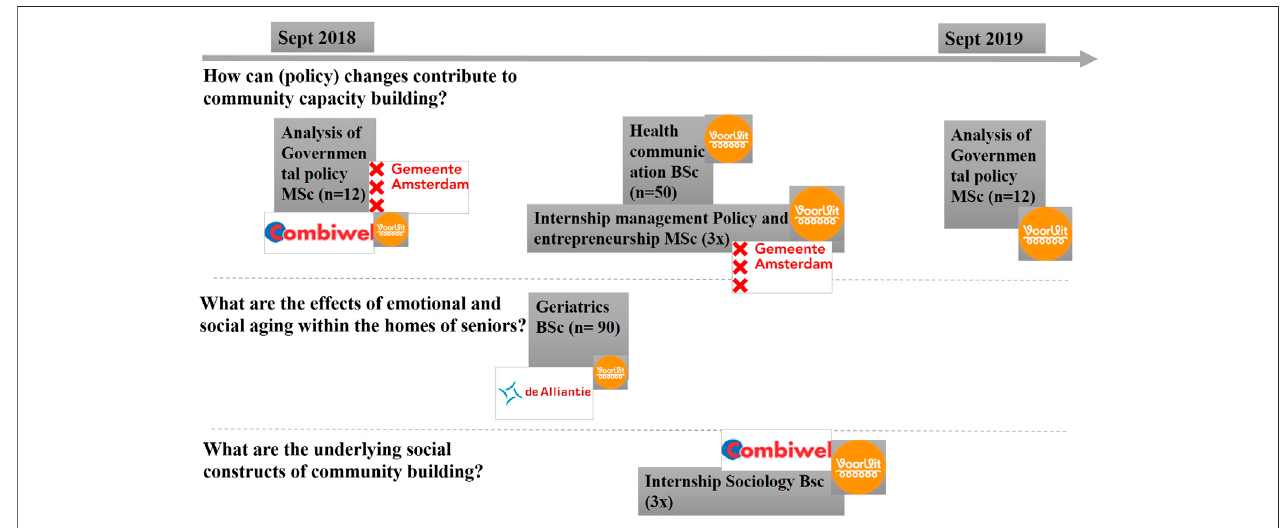
FIGURE 2 | Timeline of loneliness